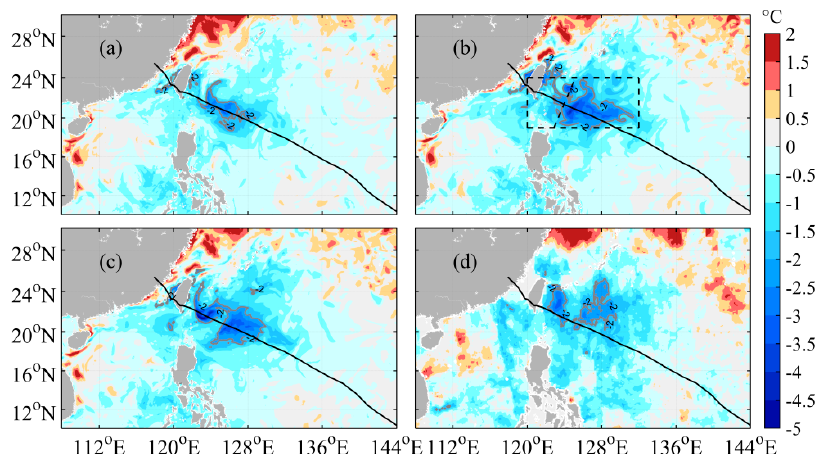
Figure 5. Distribution of SST variations of the three experiments and observations on 11 July (( a ) EX1; ( b ) EX2; ( c ) EX3; ( d ) MW_IR). The black line indicates the TC path. The − 2 ◦ C contour is marked. The black dashed box indicates the region of Figure 12. The black dashed line shows the profile perpendicular to the track.